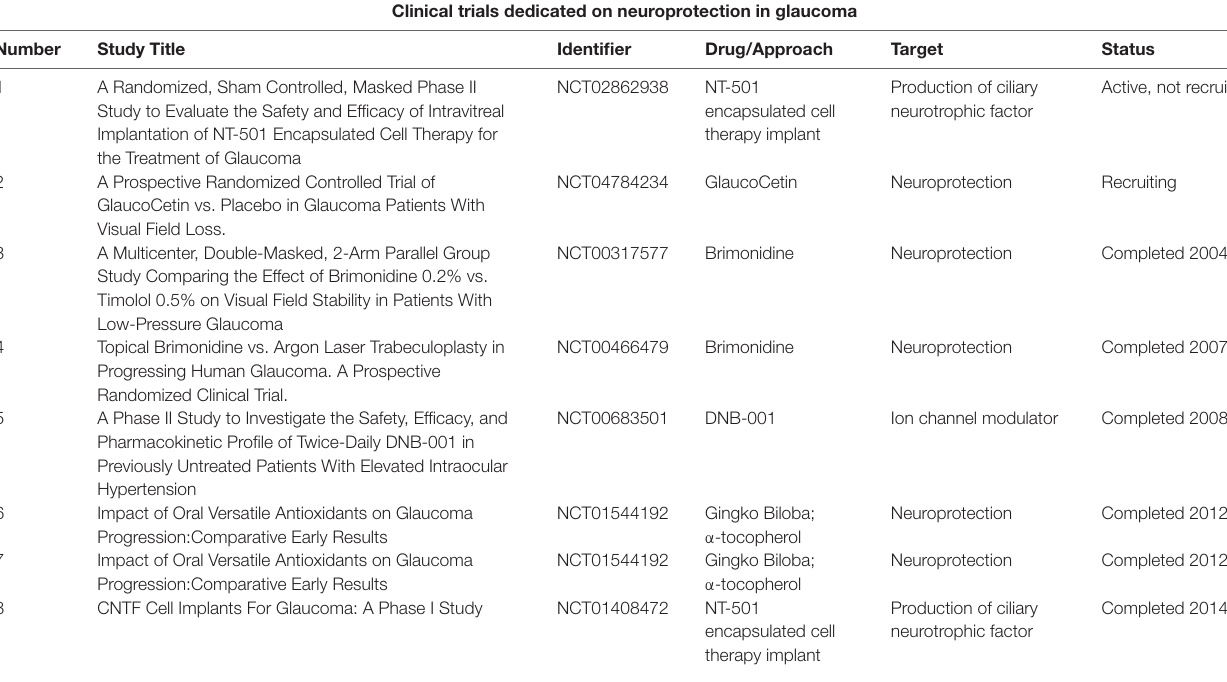
TABLE 2 | Clinical trials dedicated on neuroprotection in glaucoma (from https://clinicaltrials.gov/). Clinical trials dedicated on neuroprotection in